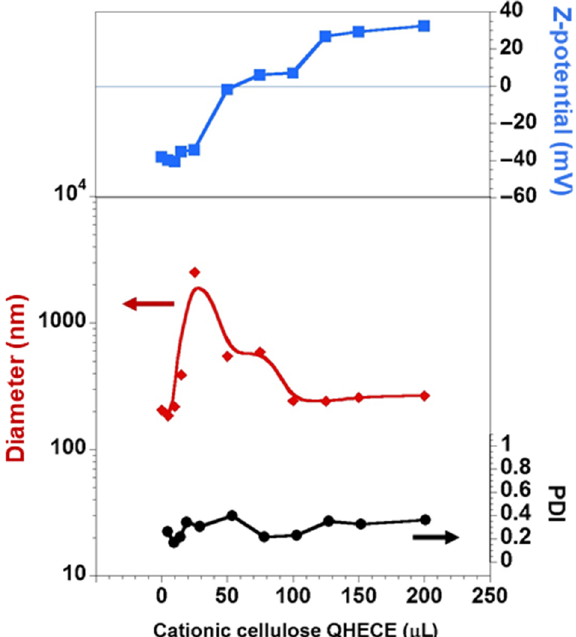
Figure 3. Changes of the average size, PDI, and ζ -potential of the DDAB/CMC vesicles upon the progressive addition of QHECE. The average values are found to have a relative standard deviation lower than 3%. Lines are just guides for the eyes.